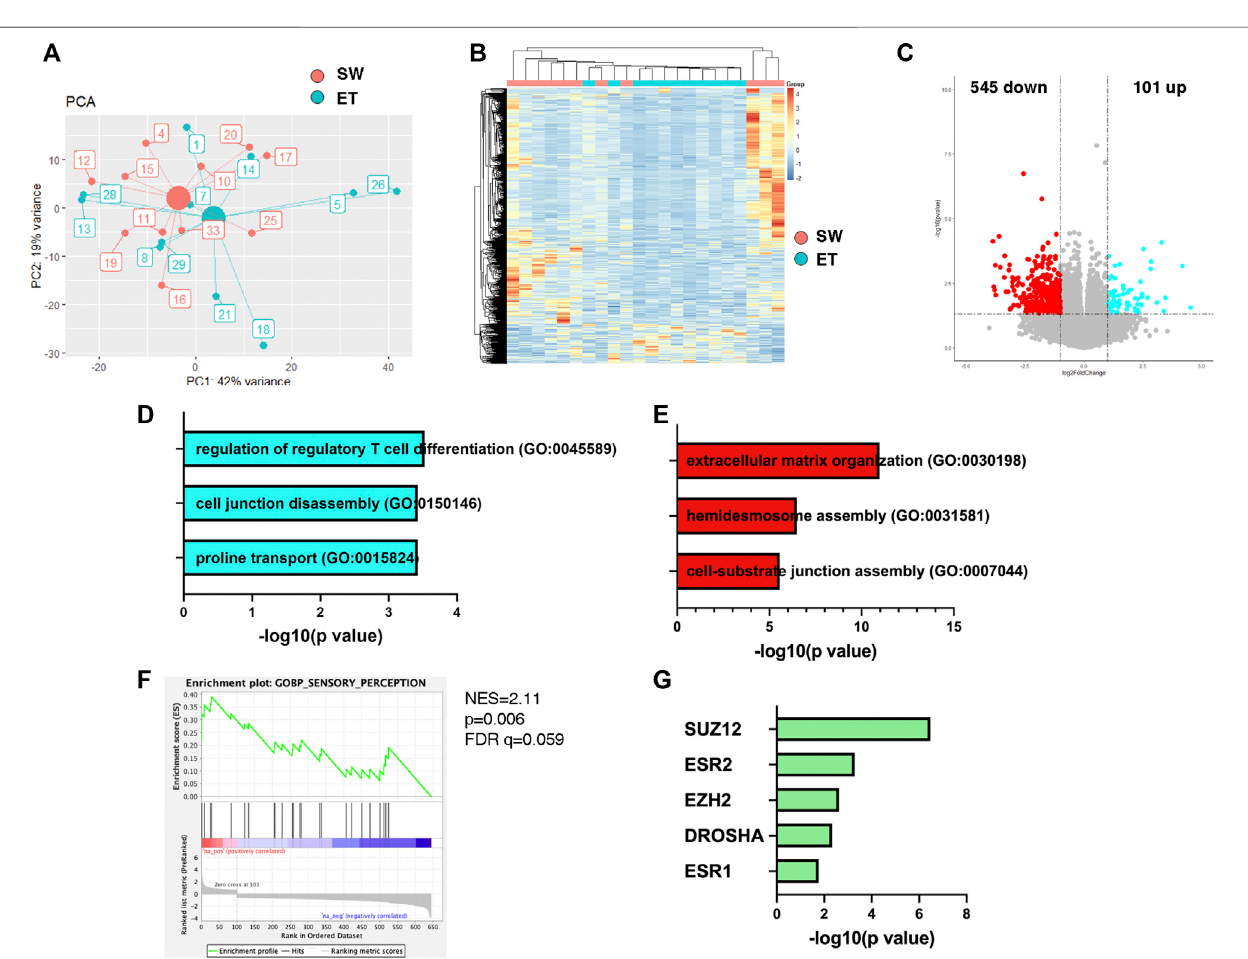
FIGURE2| Robustplacentaltranscriptomechangesareassociatedwithinfanttemperament. (A) Principalcomponentanalysisonthetranscriptomeofinfantswith Easy (ET) and Slow-to-Warm-up (SW) Temeprament. Small circles denote each subject, and big circiles represent the centroid of each group. (B) Heatmap of placental transcriptome from infants with Easy (ET) or Slow-to-Warm-up (SW) temperament. (C) Top differentially expressed genes ( p < 0.05, fold change > 1.5) were identi fi ed, with 545 genes downregulated (red) and 101 genes upregulated (blue) in placenta of infants SW temperament. (D) The gene ontology category of transcripts with higher expression in the samples from infants with SW temperament, was associated with regulation of regulatory T cell differentiation. (E) For the downregulated transcriptsintheplacentalsamplesforminfantswithSWtemperament,themostsigni fi cantgeneontologycategoriesrelatedtoextracellularmatrixorganizationandcell- substrate interaction. (F) In particular, gene set enrichment analysis (GSEA) identi fi ed gene sets regulating sensory perception were enriched in the infants with SW temperament. (G) ChIP Enrichment Analysis (ChEA) revealed chromatin remodeler in the Polycomb complex 2 (e.g., SUZ12, EZH2), microRNA processing (e.g., DROSHA), and transcription factors in Estrogen Receptor family (e.g. ESR2, ESR1) share the most signi fi cant overlapping targets and binding site proximity to the differentially expresses genes in the placental samples from infants with SW